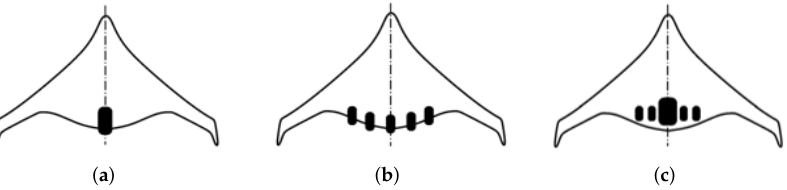
Figure 7. Propulsion Analysis. ( a ) Single propulsion; ( b ) Homogeneous Distributed Propulsion; ( c ) Heterogeneous Distributed